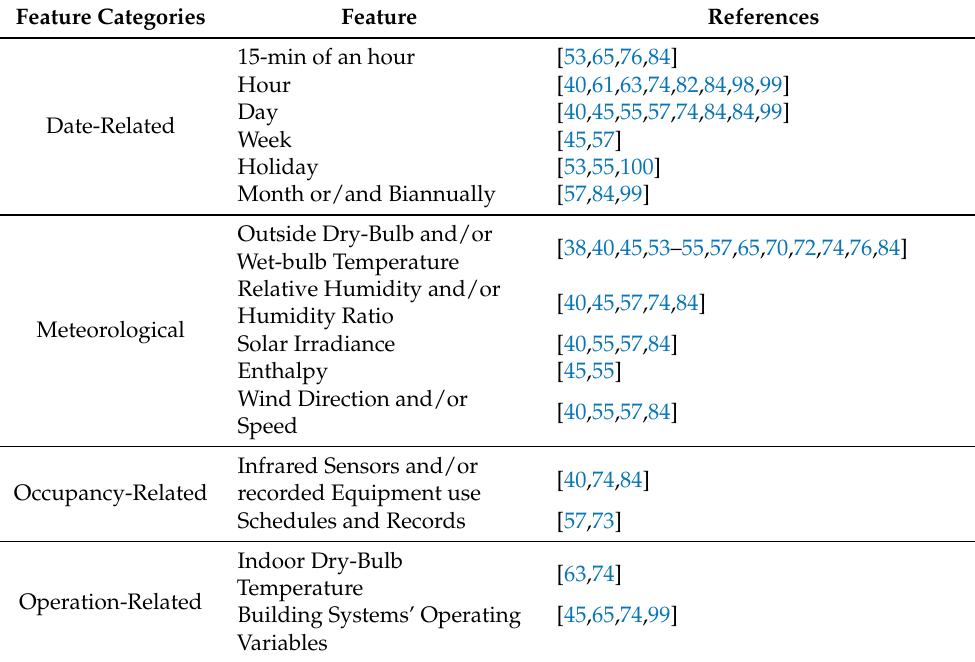
Table 7. Features used in building energy consumption